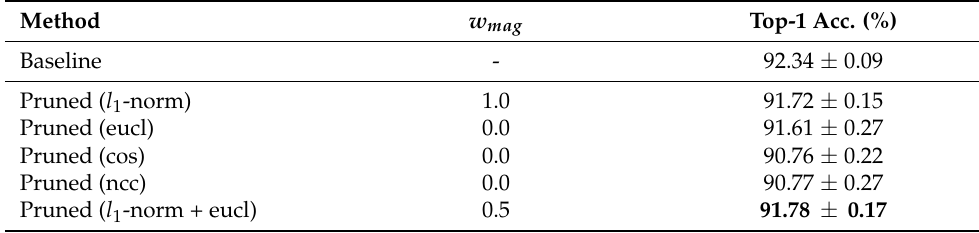
Table 3. Pruning ResNet-20 on the CIFAR-10 dataset using different filter selection criteria. Method w mag Top-1 Acc. (%) Baseline